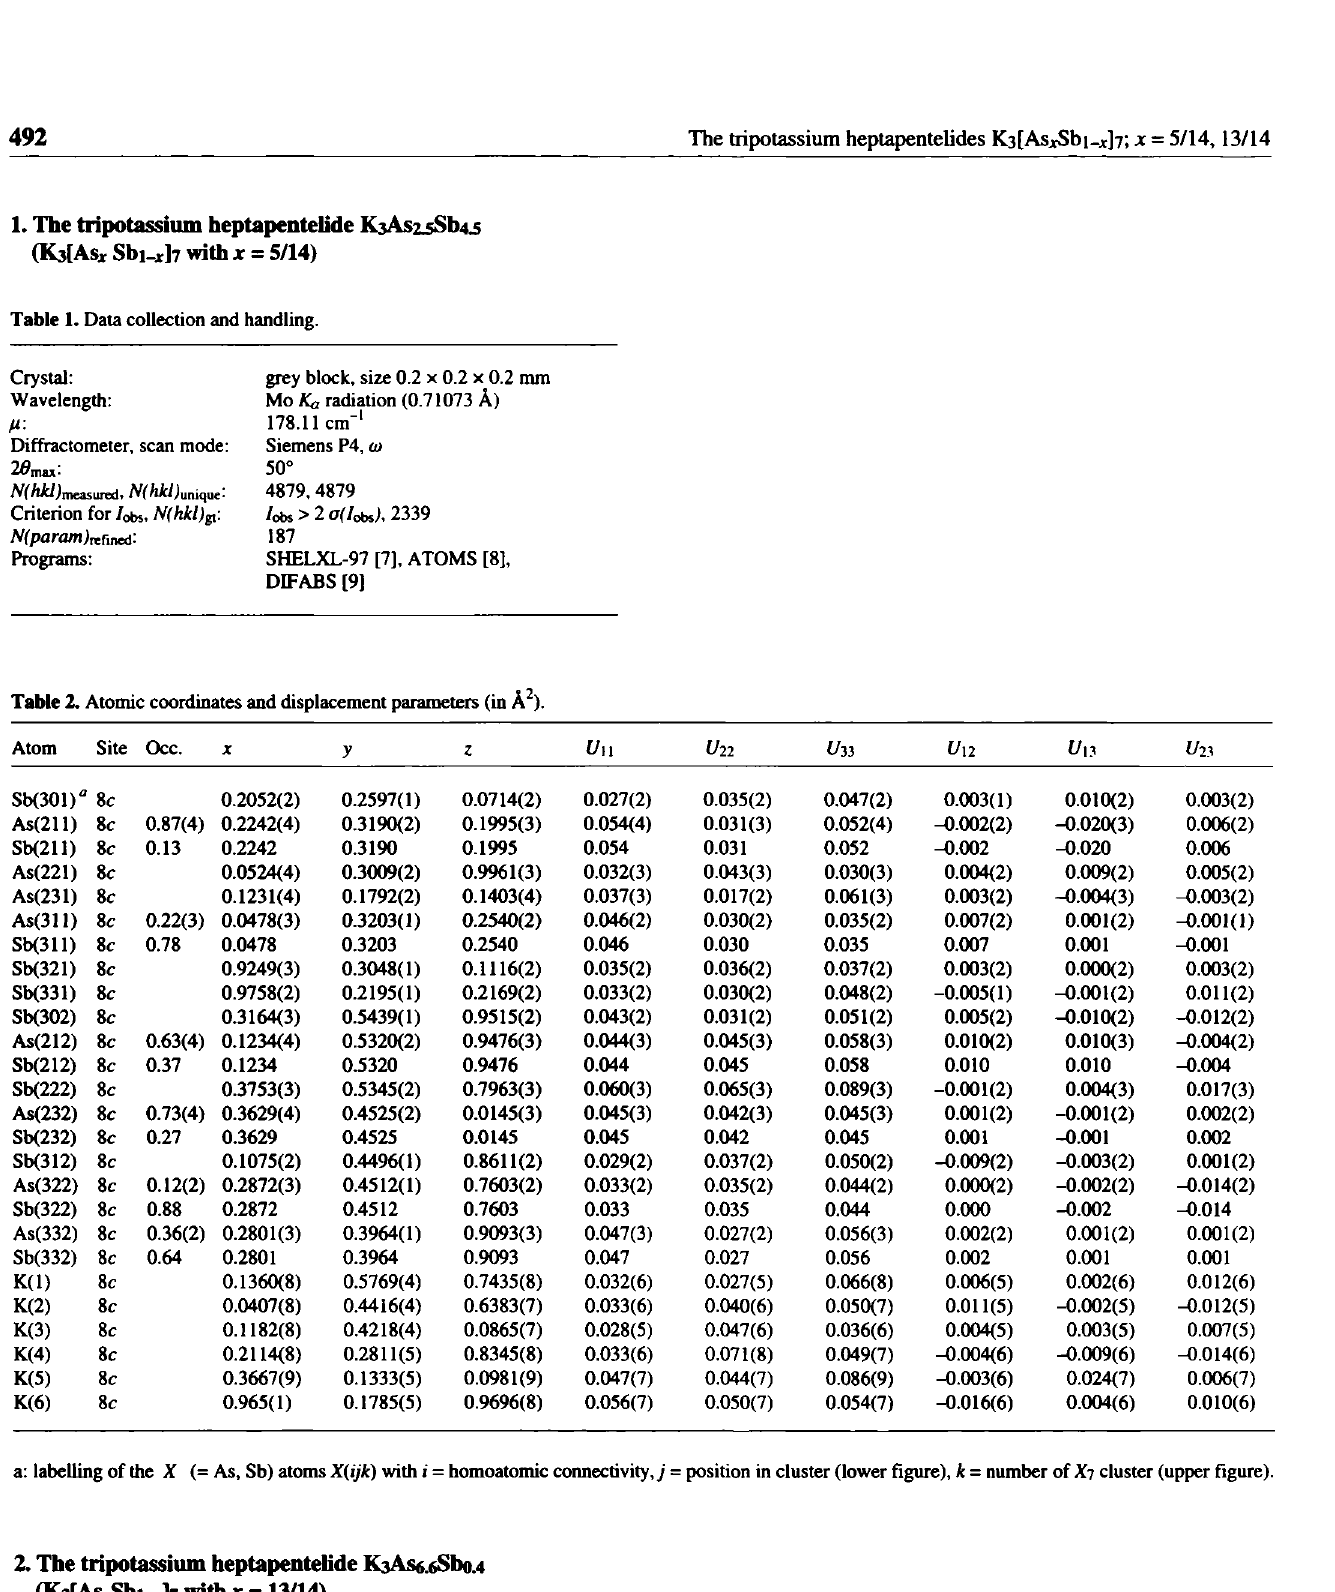
Table 3. Data collection and